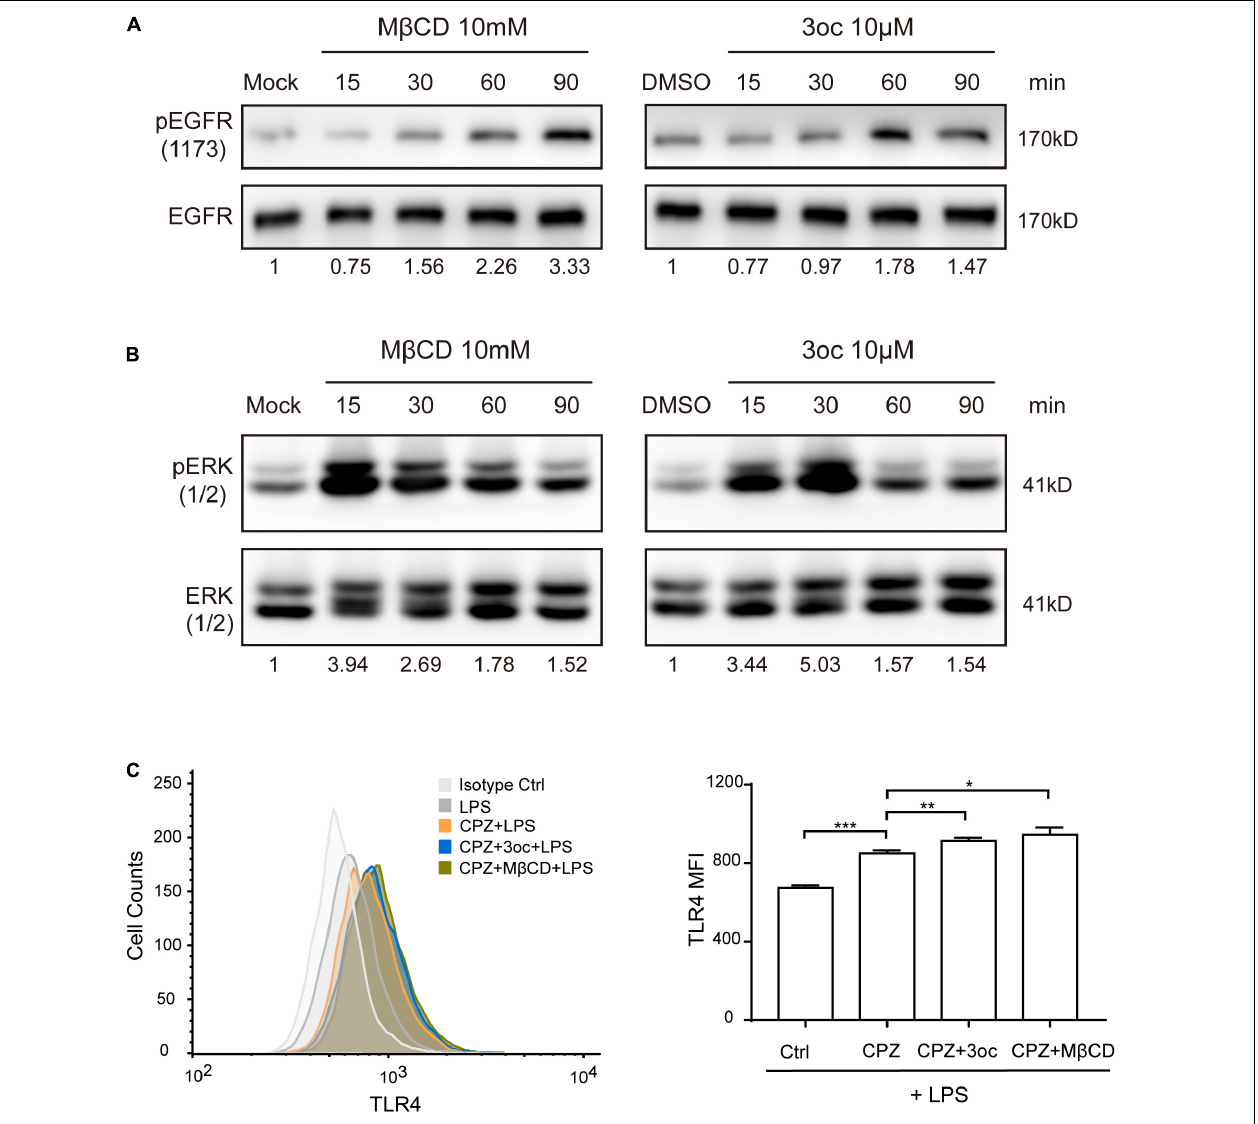
FIGURE 4 | The effects of lipid-ordered domain disruption on cell signal transduction. (A) M β CD and 3oc treatments induce spontaneous phosphorylation of epidermal growth factor receptor (EGFR) at tyrosine 1,173 at the indicated time. (B) Lipid-ordered domain disruption leads to a similar extent of extracellular signal-regulated kinase (ERK) phosphorylation. (C) The disruption of the lipid-ordered domain leads to the obstruction of lipid raft-dependent endocytosis of TLR4, the left panel is the representative histogram of the flow cytometry expression of TLR4 on THP-1 cells treated with LPS (10 µ g/ml), LPS + CPZ, LPS + CPZ + 3oc, or LPS + CPZ + M β CD, and the right panel is the quantitative data shown as mean fluorescence intensity ± SEM. The values reported under each blot are densitometry analysis relative to controls taken as 1 after normalization by internal reference. All experiments were repeated three times.